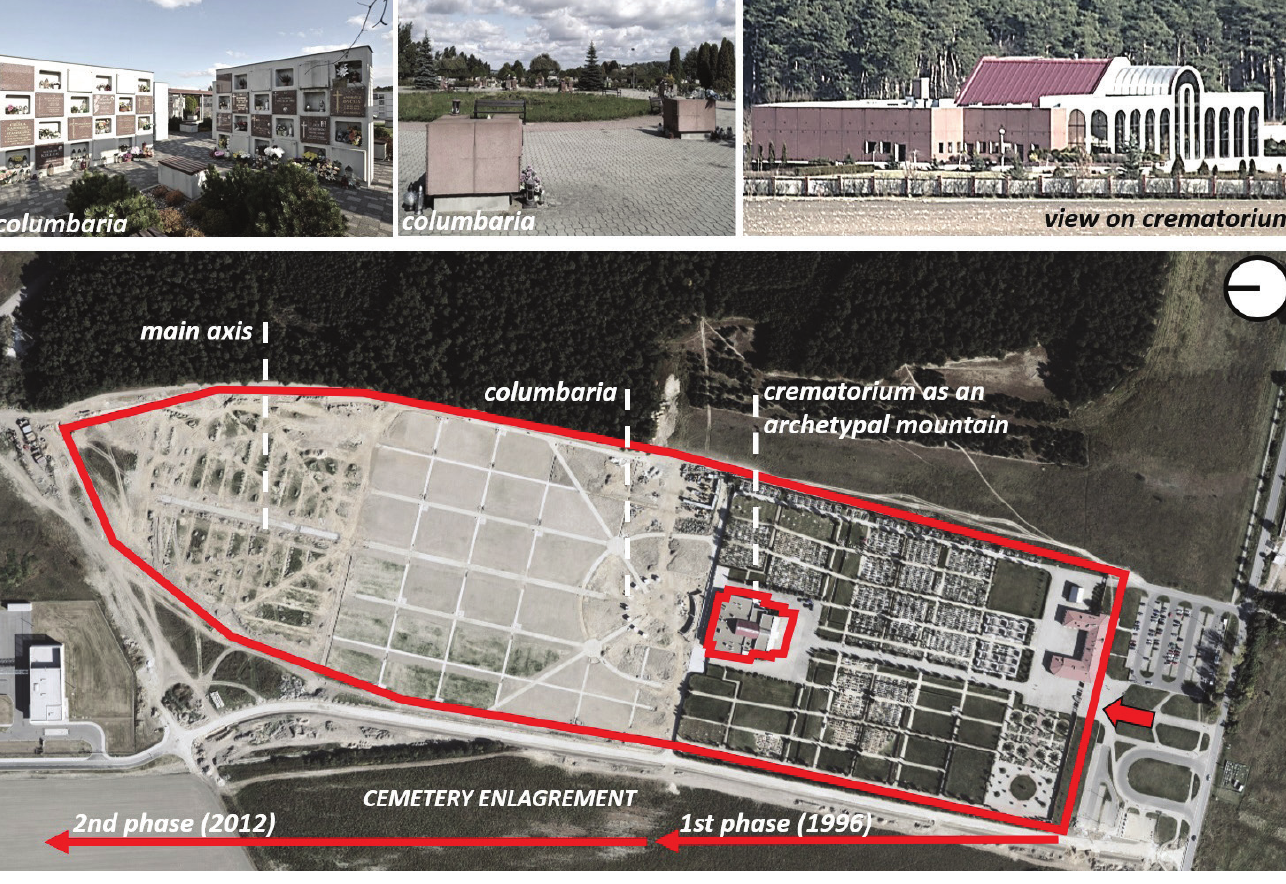
Figure 10. Crematorium in the program and structure of the cemetery affects its composition, municipal cemetery in Wrocław. Own